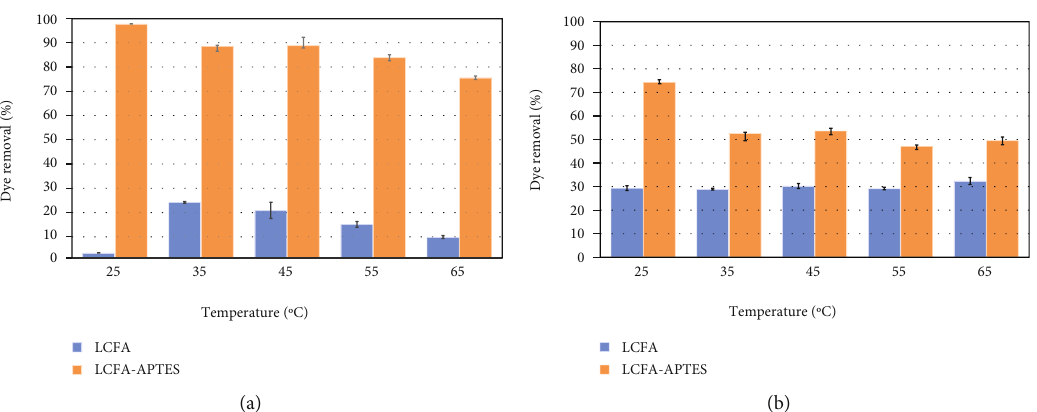
Figure 5: E ff ect of temperature on dye removal percentage: (a) MO ( pH = 4 , t = 5 min , amount of adsorbent 10 mg) and (b) XO ( pH = 4 , t = 5 min , amount of adsorbent 20 mg) by LCFA and LCFA-APTES. The error bars represent the standard deviation of at least three repeated measurements at each temperature value.